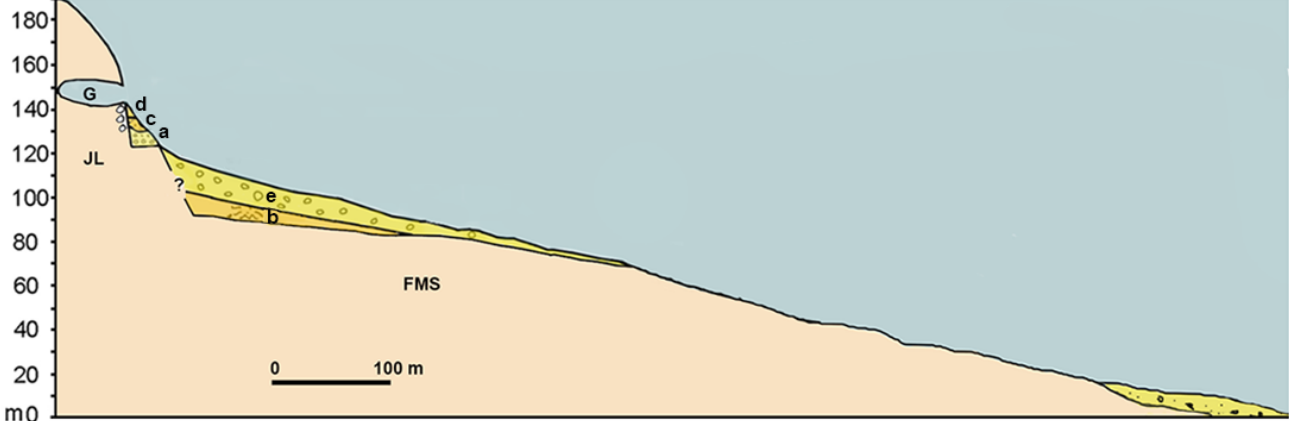
Figure 5. ( A ) the carbonate massif of Pizzo Castellaro where San Teodoro Cave opens (arrowed) with terraces above and below it. ( B ) the entrance of the cave.